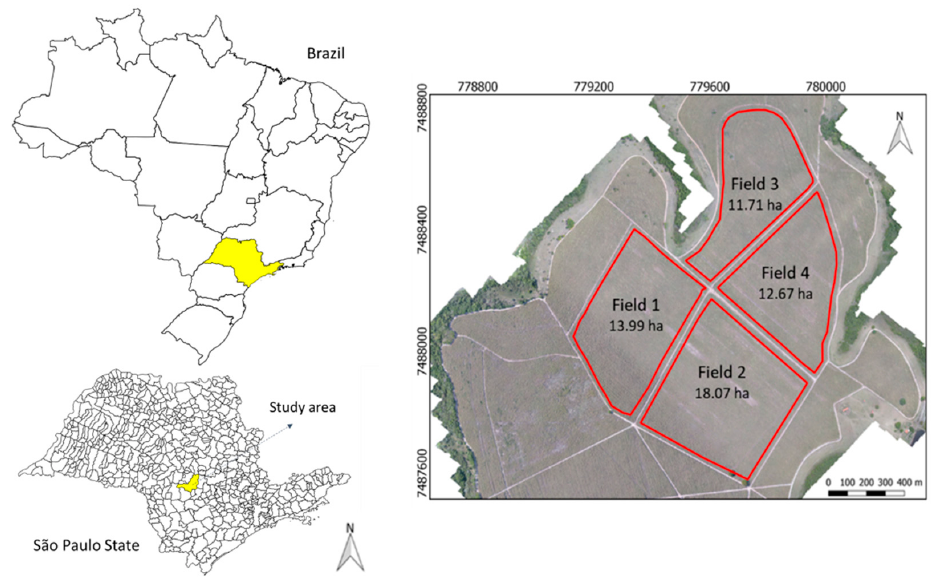
Figure 1. Location of sugarcane fields study site in Brazil.